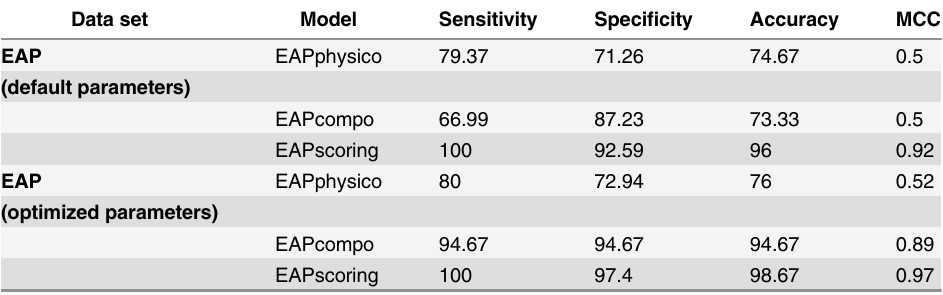
Table 2. Performance of the AVPpred and EAPpred models training set V 75p+75n . Data set